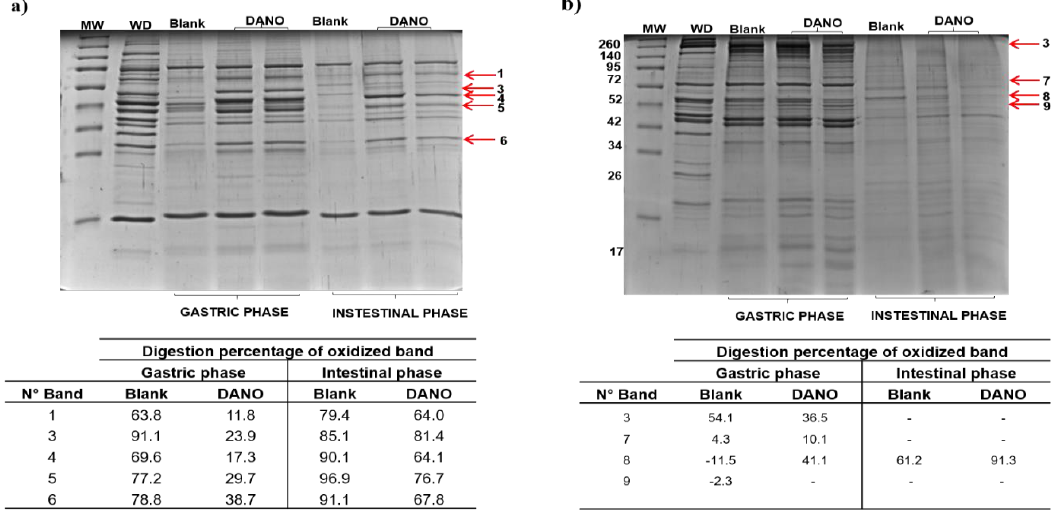
Figure 6. In vitro gastrointestinal digestion of beef proteins treated with danofloxacin at 1.0 maximum residue limit (MRL). ( a ) sarcoplasmic and ( b ) myofibrillar proteins extracted from blank and treated samples subjected to gastric and intestinal digestion. The digestion electrophoretic profiles were realized in 15% SDS-PAGE. Arrows indicate oxidized bands selected for the follow-up of their gastric and intestinal phases. MW: molecular marker; WD: protein not digested.